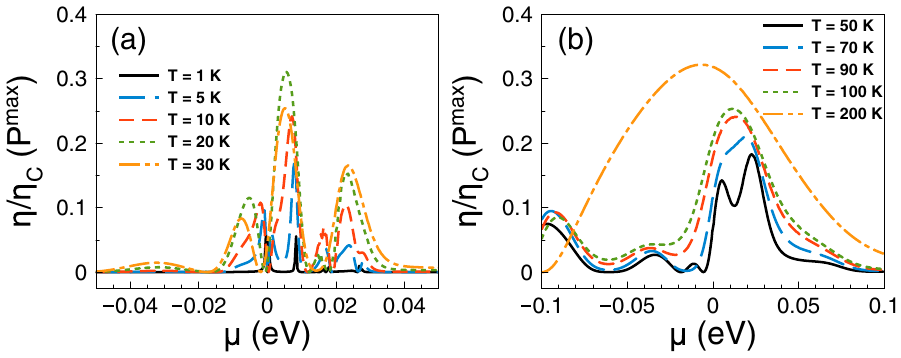
Figure 21. The same as Fig. 14, but for d B = d W = 10 nm. In this case, we also have more options for an acceptable output power and a good efficiency owing to the different resonances in the double barrier structure.